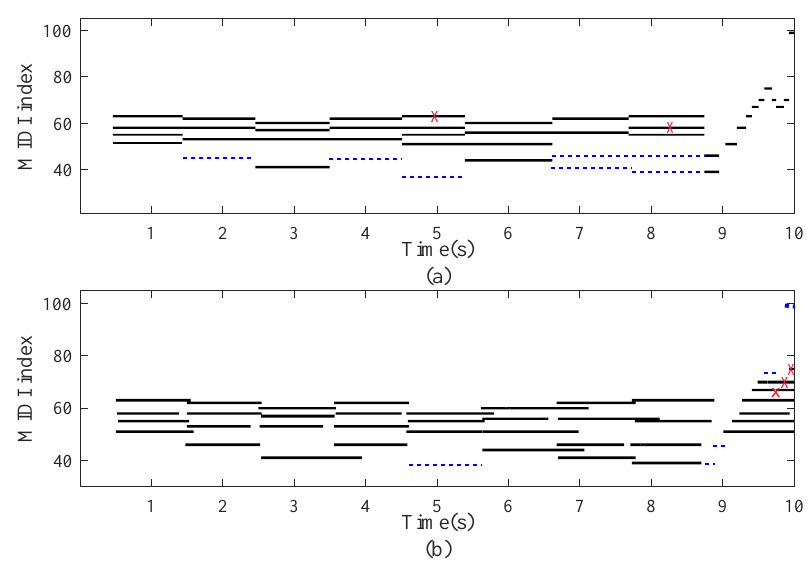
Figure 10. Results of specific piano transcription: ( a ) the transcription of our proposed system and ( b ) the transcription of Cheng’s